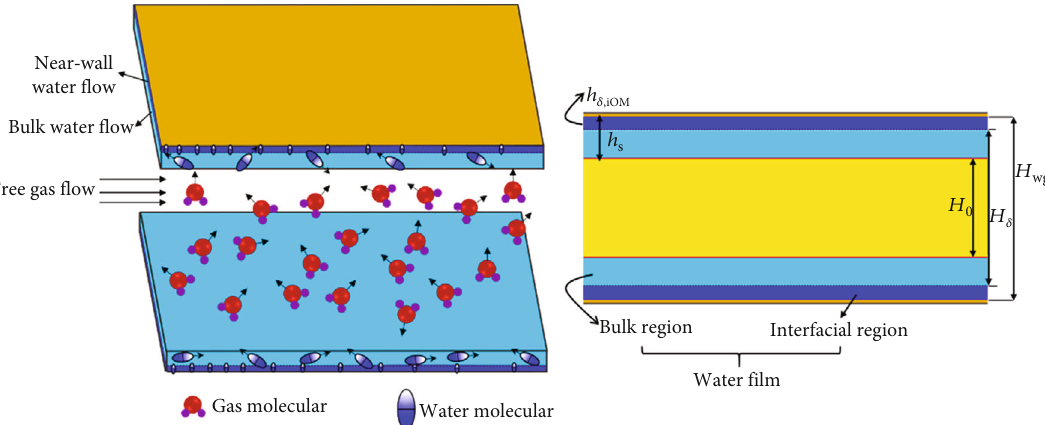
Figure 2: Illustration of the gas-water fl ow in nanoscale inorganic pores (viscous and slip fl ow of free gas in the pore center and the viscous fl ow of near-wall water and bulk